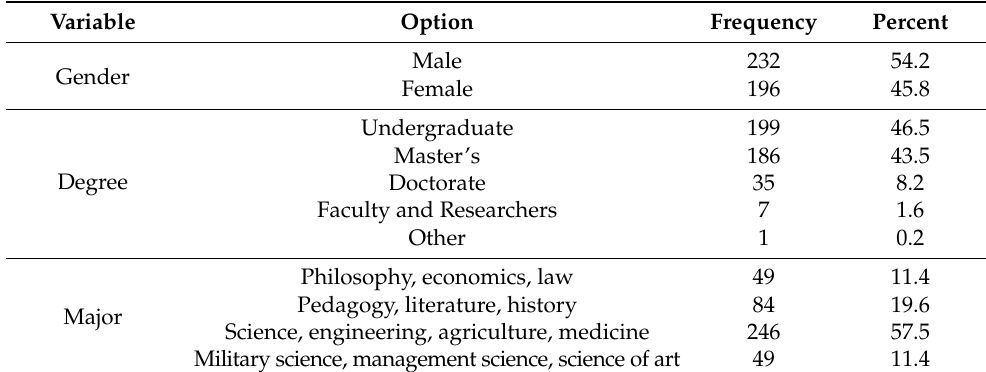
Table 7. Descriptive statistics for all participants ( n = 428, Wuhan, China, 2021–2022).